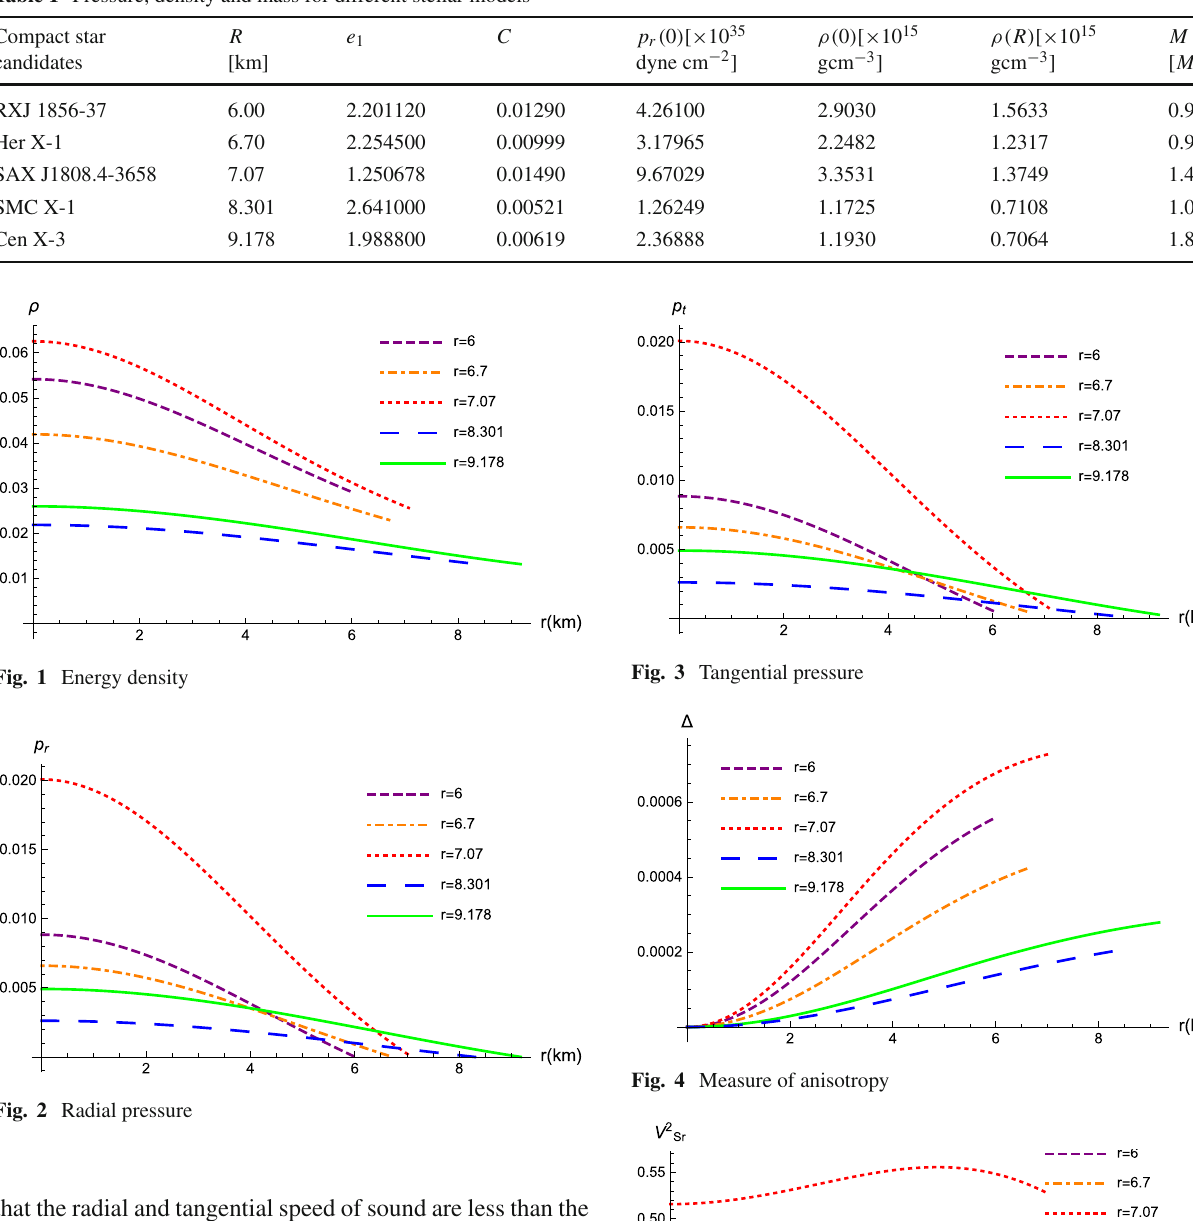
Fig. 4 Measure of anisotropy